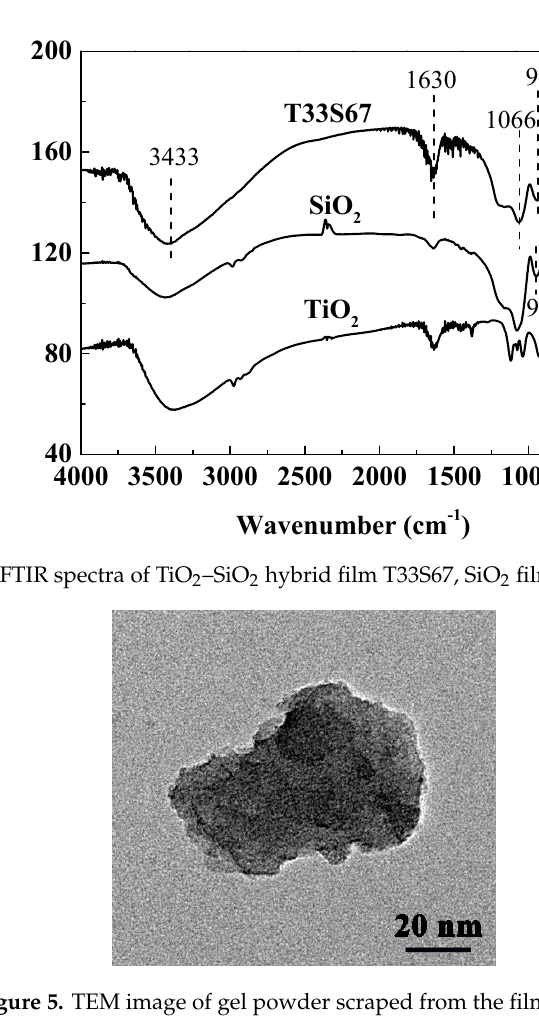
Figure 5. TEM image of gel powder scraped from the film T33S67.